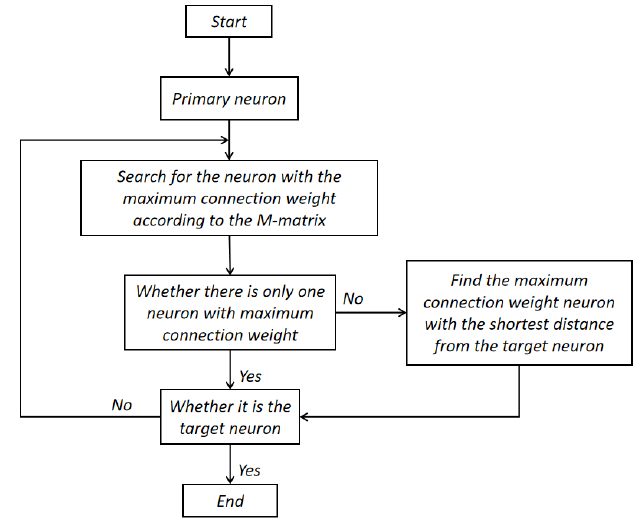
Figure 1. Flow chart of situational memory navigation.